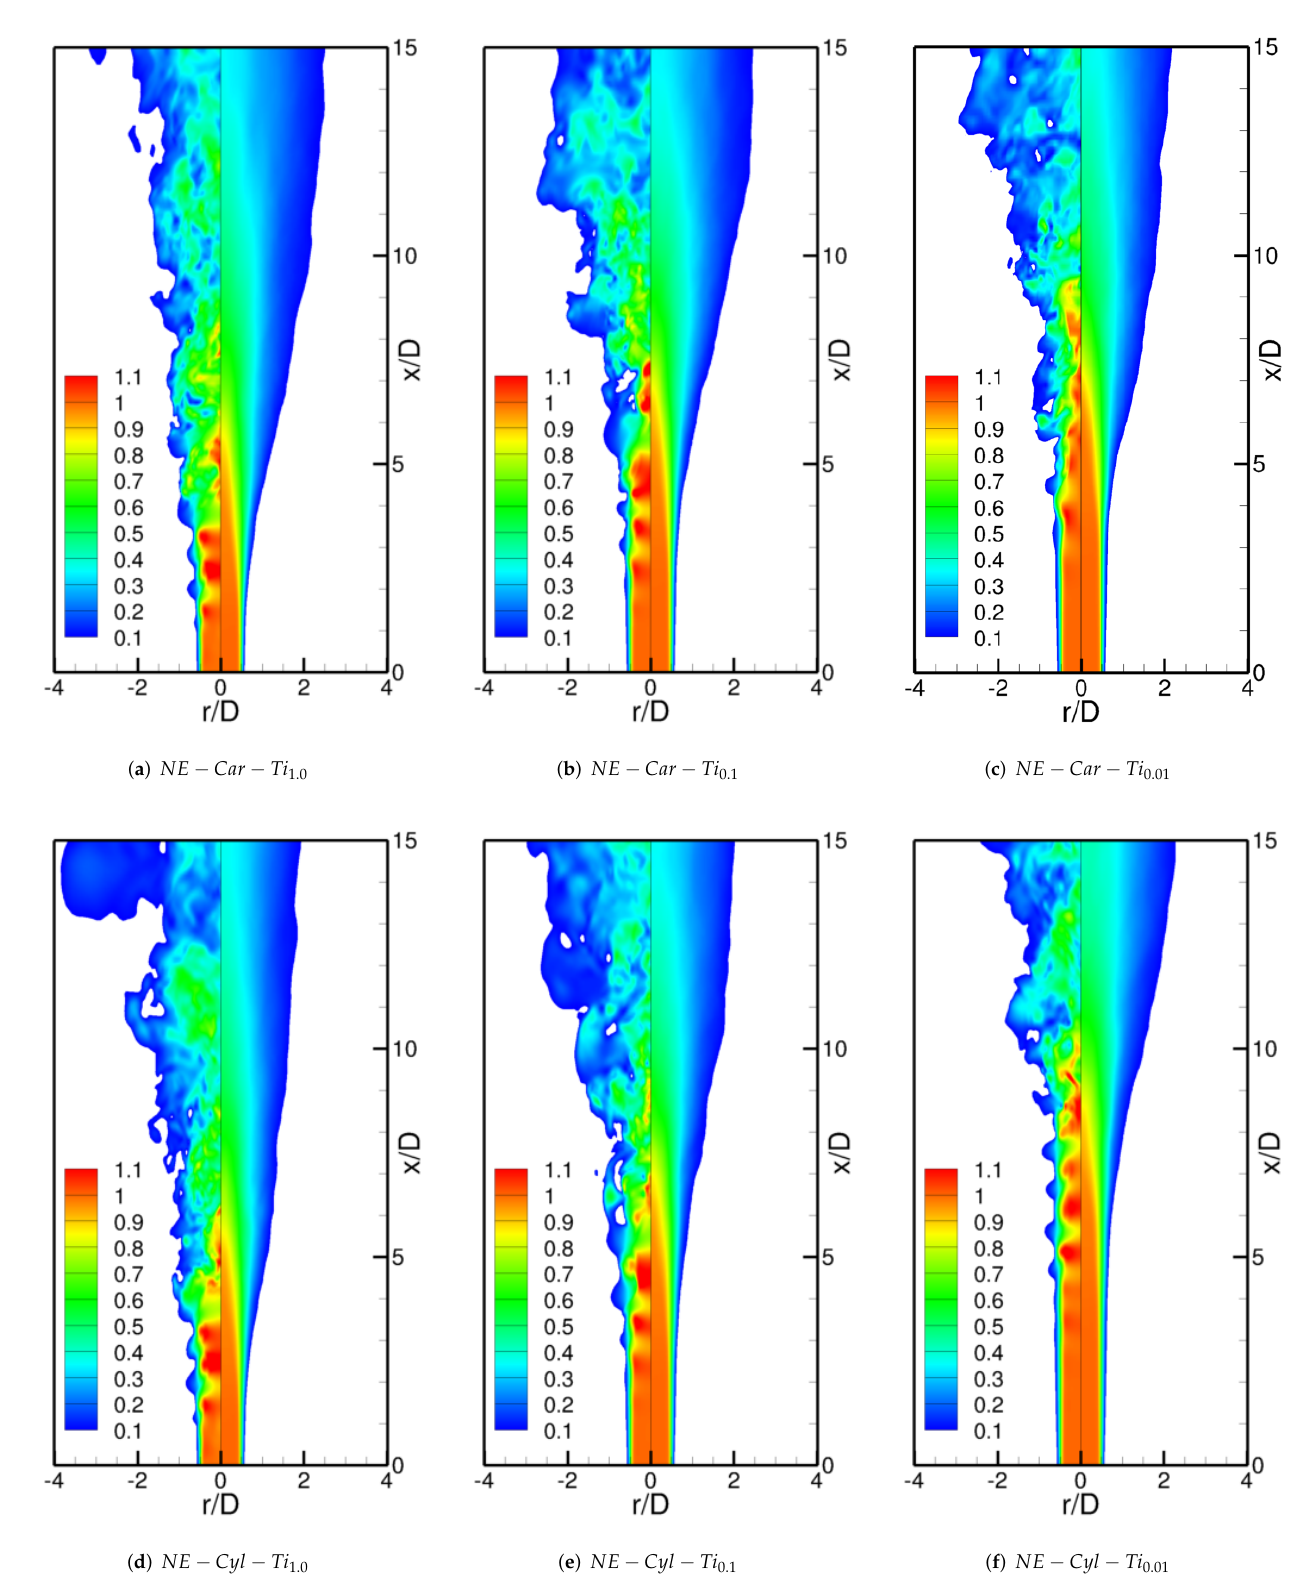
Figure 5. Contours of instantaneous ( left sides of the subfigures) and time-averaged ( right sides of the subfigures) values of the axial velocity U x / U 0 in the central cross-section in the Cartesian and cylindrical coordinate systems obtained for Ti = 0.01%,0.1% and